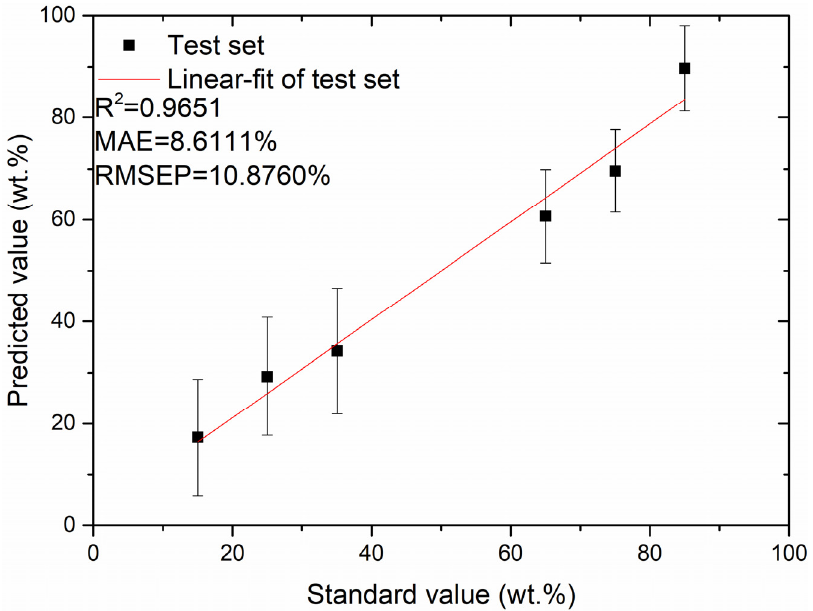
Figure 2. Plot of relationship between predicted and standard values of the test set obtained using the PLSR quantitative analysis method under NM data normalization.